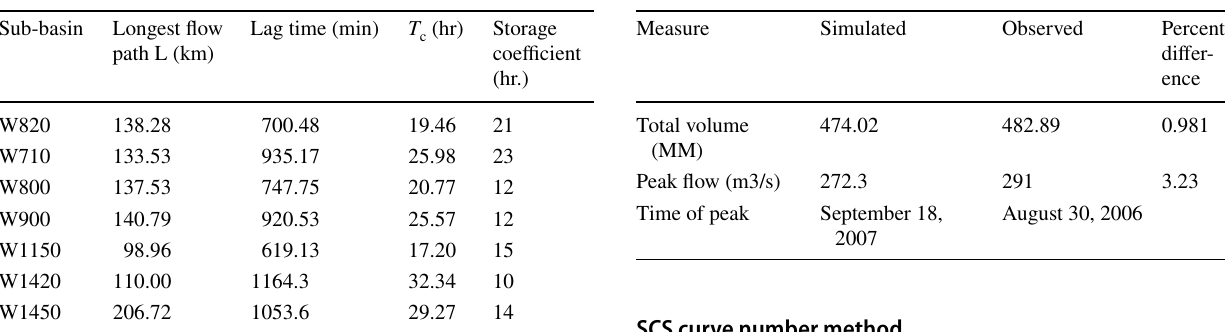
Table 8 Clark UH initial model parameters Table 9 Calibration result for initial and constant loss